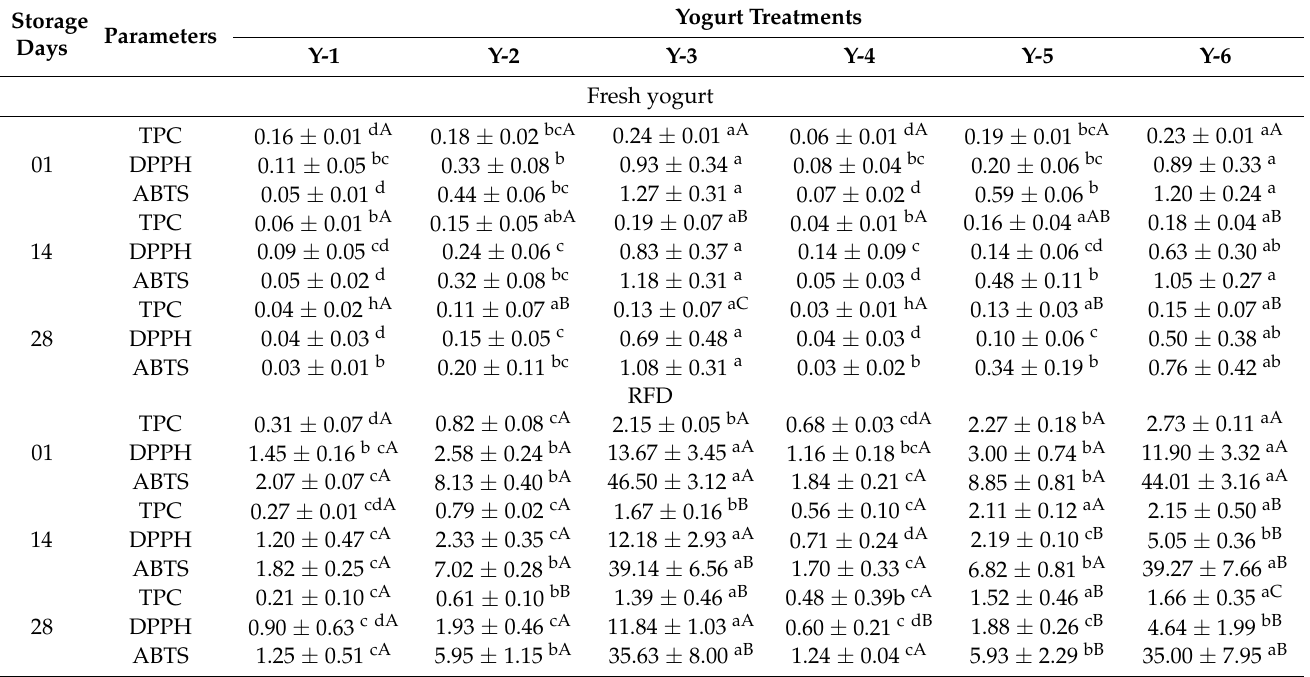
Table 5. Phenolic contents (mg GAE/g sample) and antioxidant activities (mM TE/g sample) in fresh and RFD yogurts during refrigerated